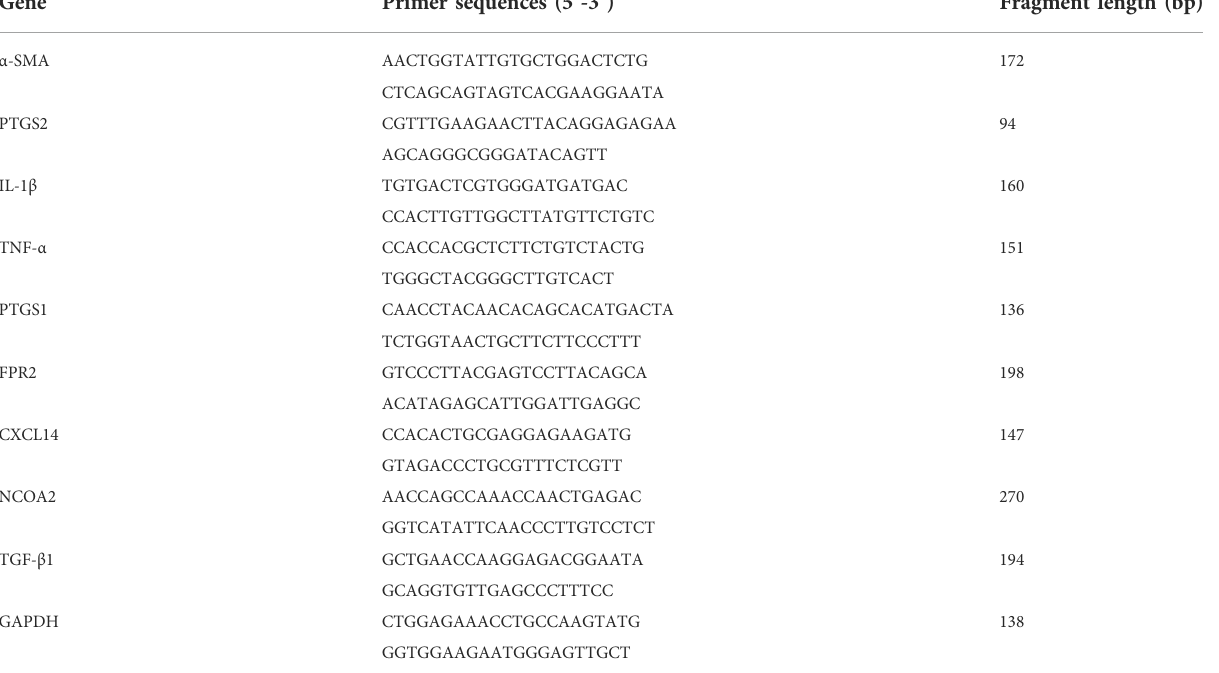
TABLE 1 Primers for real-time reverse transcription-polymerase chain reaction